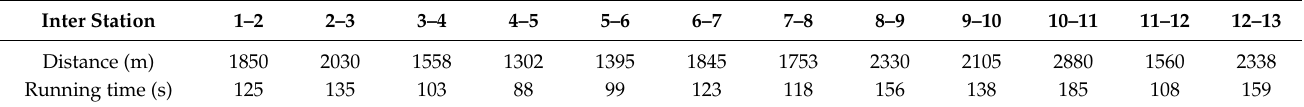
Table 3. Running distance and running time between stations.